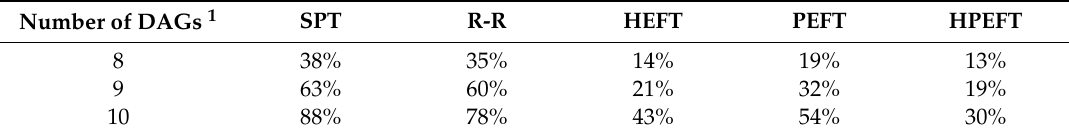
Table 12. MDRs of test 3.